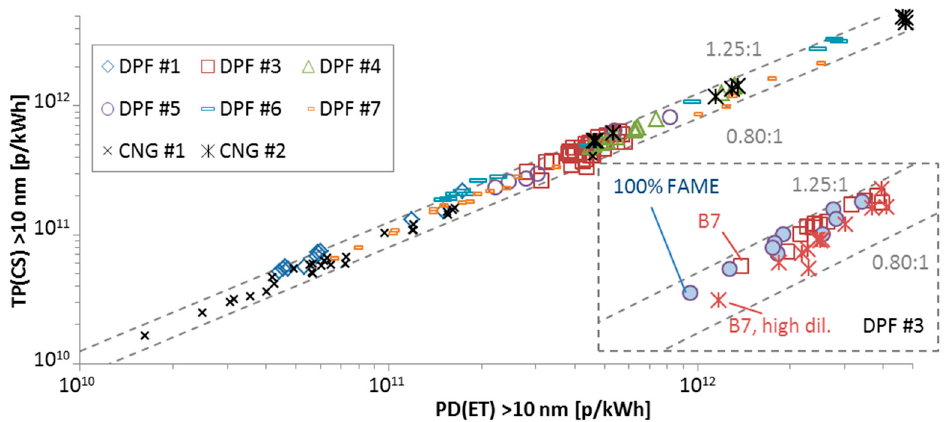
Figure B2. Comparison of “Golden” system TP(CS) with instruments at proportional partial flow dilution systems PD(ET) with the CPCs measuring > 10 nm. Acronyms as Figure B1.